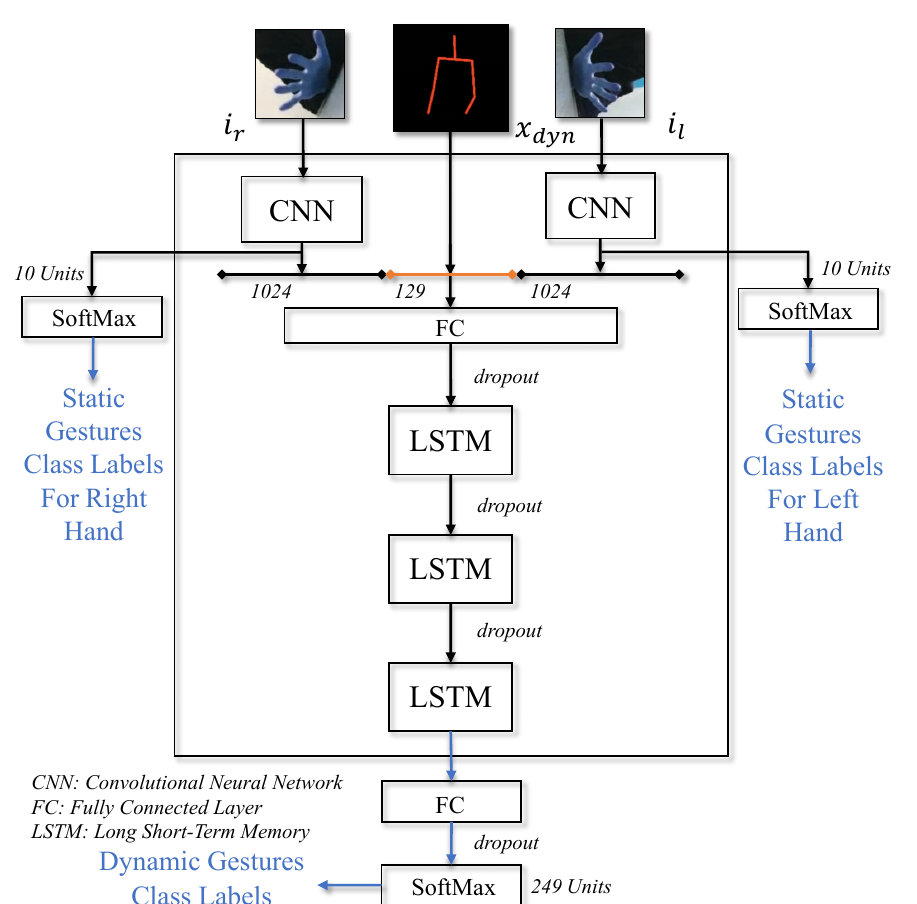
Figure 4. Illustration of StaDNet for static and dynamic gestures recognition. We perform intermedi- ate fusion to combine hand image embeddings and augmented pose